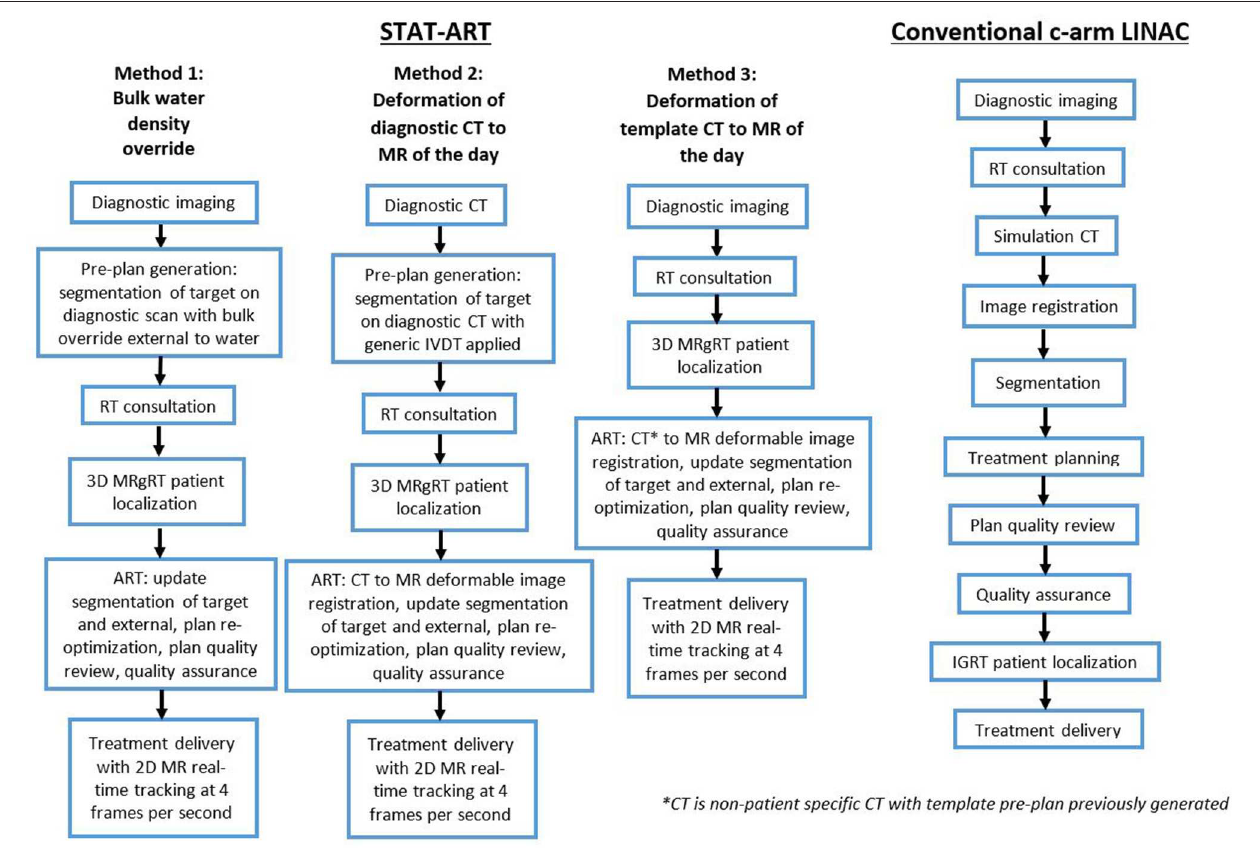
FIGURE 1 | Workflow of three proposed methods of STAT-ART (left) compared to the standard of care for palliative treatment as performed on a conventional c-arm linac (right)